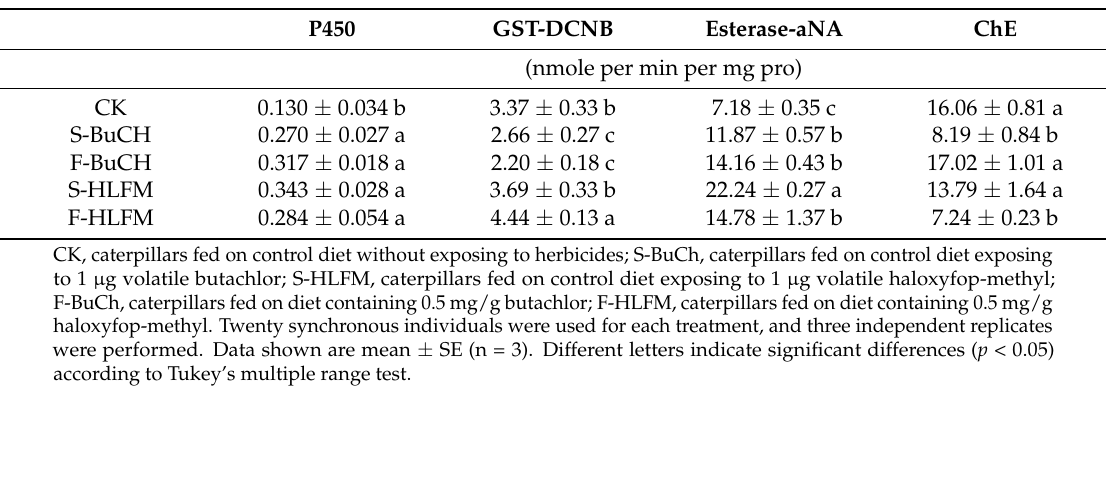
Table 2. Activities of detoxification enzymes in fat body of H. armigera